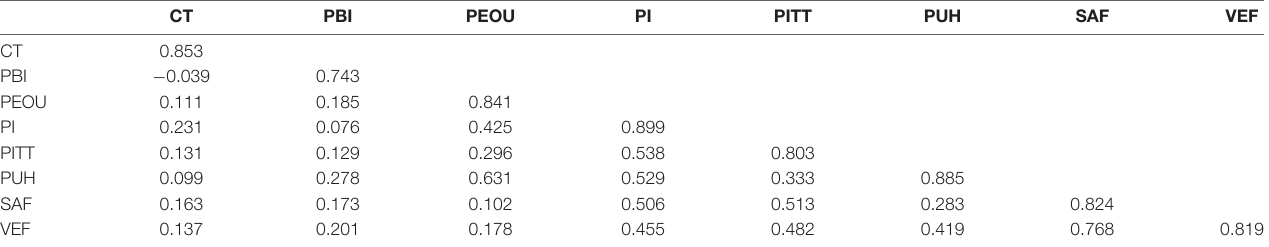
TABLE 3 | Fornell and Larcker’s (1981) criterion.